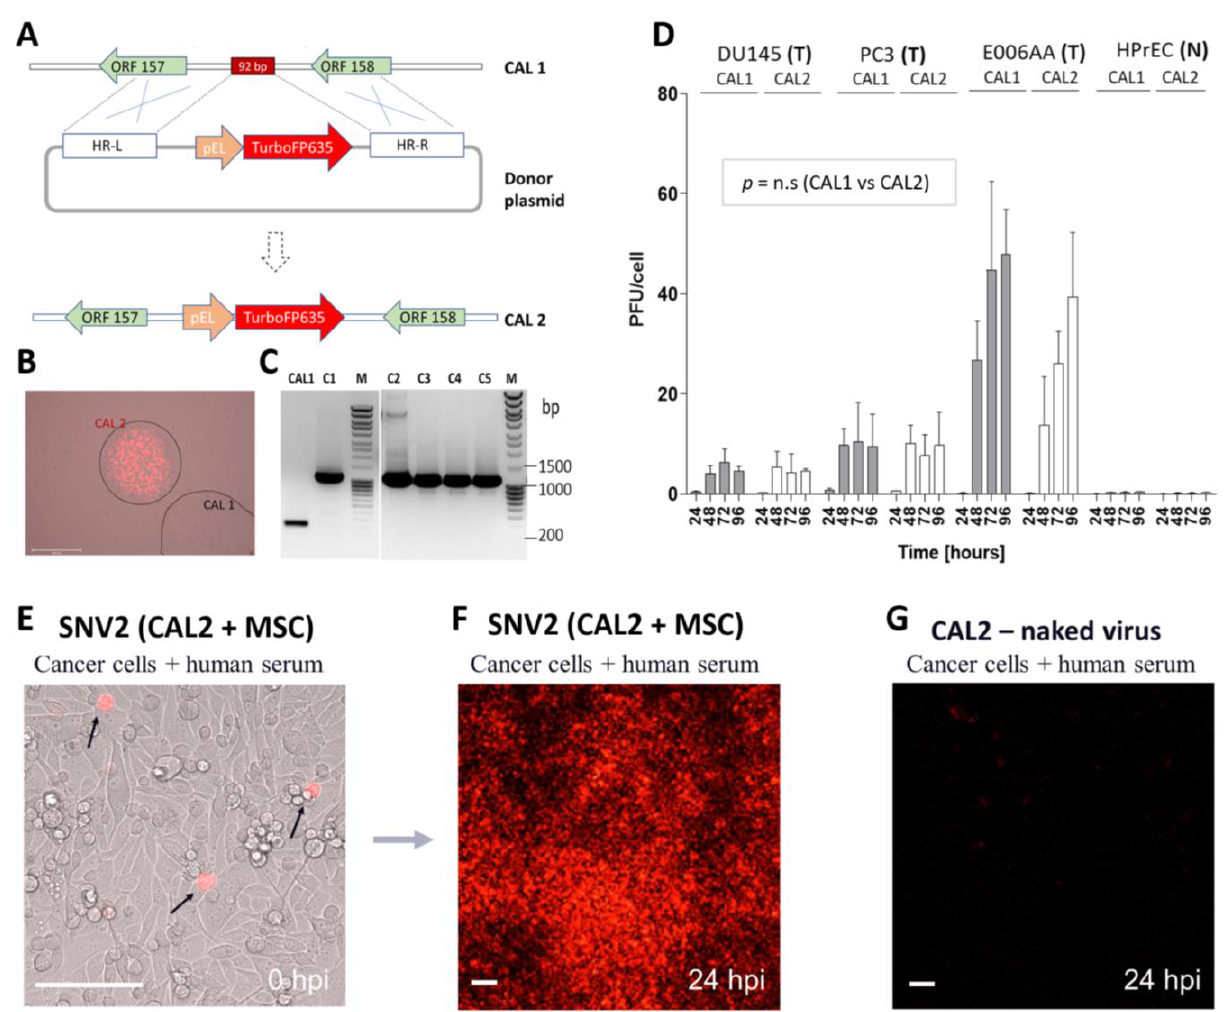
Figure 4. CAL1 vaccinia virus as a backbone to express therapeutic genes in the context of MSC delivery to cancer cells. ( A ) Strategy to generate new armed virus using CAL1. The intergenic locus in CAL1 genome was cut by Cas9HFc/gRNA, which trigger homologous recombination between CAL1 and the donor vector. As an example, TurboFP635 expression cassette from the donor vector was exchanged for the 92 bp fragment in the intergenic locus of CAL1, resulting in the recombinant virus, CAL2. ( B ) Generation of CAL2 virus. During clonal selections of CAL2, the recombinant CAL2 virus expressing TurboFP635 (red) was isolated from parental CAL1 virus (white). ( C ) Verification of generation of armed-vaccinia virus by PCR. Genomic DNA from six selected clones was used as template for PCR amplification using primers specific to the intergenic region where the TurboFP635 expression cassette was inserted. The uncropped DNA Figure can be found as Figure S1 in Supplementary Materials. The recombinant clones (C1–C6) show a PCR band with a molecular weight higher than 1000 bp while the parental CAL1 virus was only 230 bp. ( D ) Comparison of CAL1 and CAL2 tumor preferential viral amplification. The prostate cancer derived human cancer cell lines PC3, DU145, and E006AA, and the human primary prostate epithelial cell line HPrEC were synchronously infected at a MOI of 0.01 with CAL1 or CAL2. Samples were collected at 24-, 48-, 72- , and 96-h post-infection and virus amplification was analyzed by plaque assay. T = human cancer cell line. N = normal human primary prostate epithelial cell line. CAL1 Viral amplification at every time point and for every cell line was compared with CAL2 viral amplification. p = n.s (no signifi- cant) unpaired 2-tailed Student’s t test (n = 3). ( E – G ) Therapeutic potential of SNV2. PC3 prostate cancer cells were infected with SNV2 in presence of 20% human serum. ( E ) Gene of interest (for example TurboFP365) was present at time of treatment in SNV2 cells (black arrows). Picture shows overlay of bright field showing monolayer of PC3 cells and SNV2 expressing TurboFp635 fluores- cent protein detected using Invitrogen EVOS FL Auto 2 Cell Imaging System. ( F ) Twenty-four (24) hours post treatment with SNV2, massive expression of CAL2-encoded TurboFp635 was found in